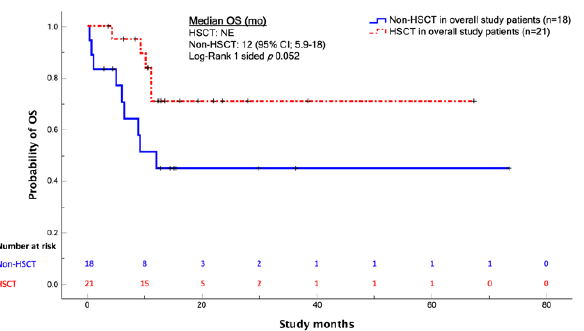
Figure 3. Comparison between patients who underwent HSCT and those who did not after achieving CR with blinatumomab treatment. ( a ) OS curves; ( b ) RFS curves. Abbreviations: OS, overall survival; HSCT, hematopoietic stem cell transplantation; CR, complete remission.